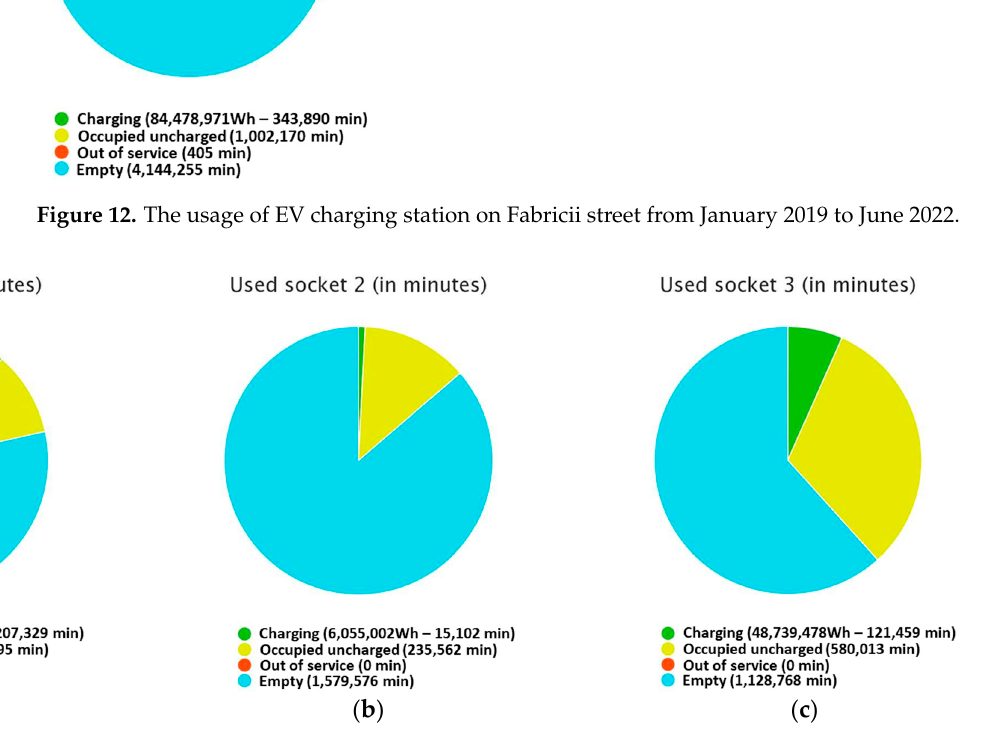
Figure 13. Usage of the charging station on Fabricii street for each socket: ( a ) charging using CHAdeMO standard; ( b ) charging using Type 2 standard; ( c ) charging using CCS standard.